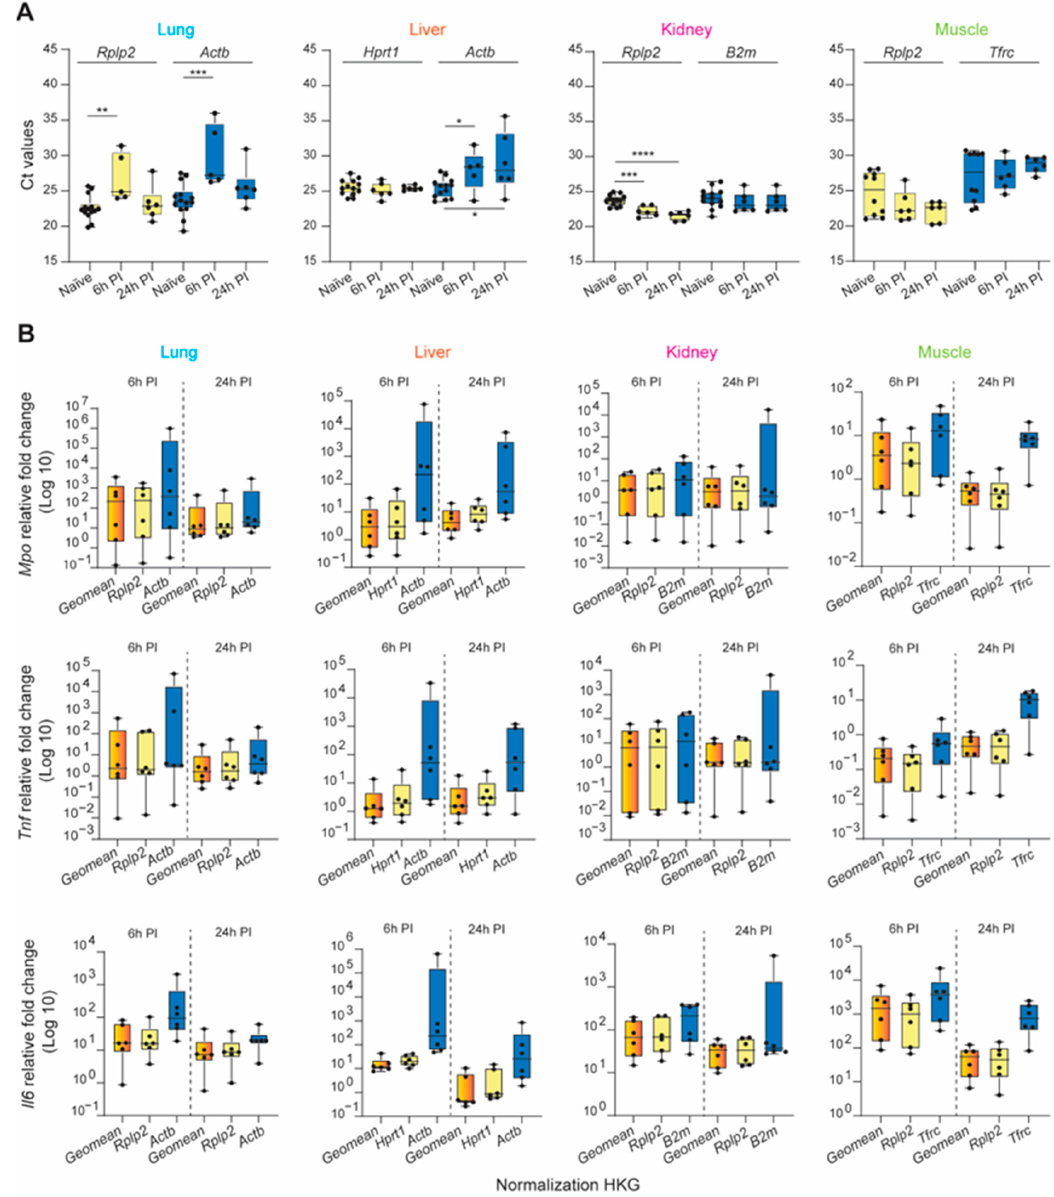
Figure 5. Validation of selected HKGs to normalized inflammatory biomarker gene expression across traumatic experimental conditions in the lung, liver, kidney, and muscle. ( A ) Average of the Ct values obtained for the most (yellow bars) and least (blue bars) stable HKGs within different timepoints: naïve, 6 h post-injury (6 h PI), and 24 h (24 h PI). Statistical significance was defined as * p ≤ 0.05; ** p ≤ 0.01, *** p ≤ 0.001, and **** p ≤ 0.0001. ( B ) Average of relative fold-change expression of inflammatory biomarkers, myeloperoxidase ( Mpo ), tumor necrosis factor ( Tnf ), and Interleukin 6 ( Il6 ), by either the geometric mean of the top three highly stable HKGs (orange bars), and the most (yellow bars) and least (blue bars) stable HKGs for the lung, liver, kidney, and muscle tissues; n = 6 rats for each experimental condition. Error bars represent standard deviations.